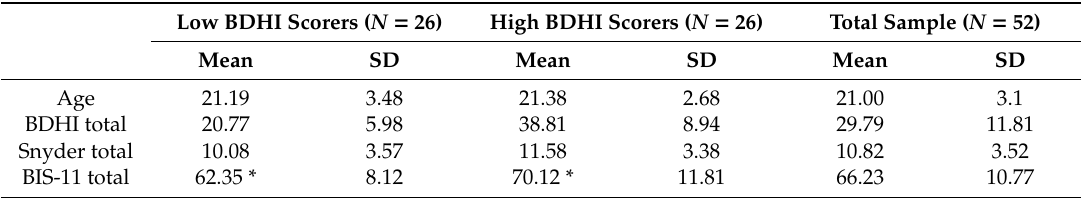
Table 2. Descriptive statistics of total scores for low and high scoring groups based on the Buss–Durkee Hostility Inventory (BDHI) and in the total